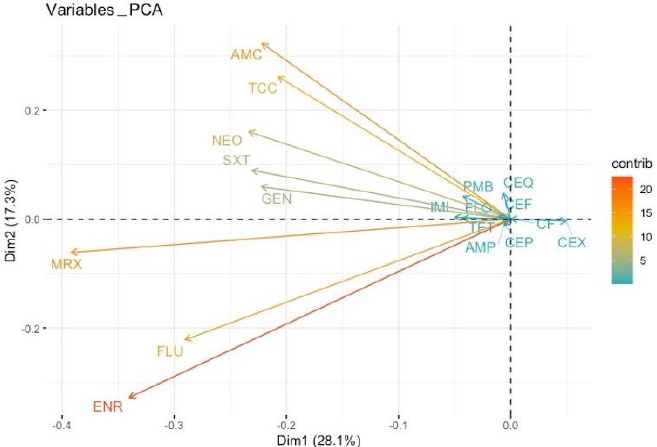
Figure 2. Principal component analysis (PCA) on co-resistances. Antibiotics are represented by vectors (arrows). Two vectors of antibiotics pointing in the same direction is an indication of a positive correlation between them; when we observe AMR in one antibiotic, we are expecting the development of AMR in the other one. An angle of 180 degrees between the vectors of two antibiotics is an indication of a negative correlation between them; when we observe AMR in one, we are not expecting the development of AMR in the other. A 90-degree angle between the vectors of two antibiotics indicates no relationship between them toward the developing AMR. The longer the vectors, the greater the intensity of this relationship. AMP: ampicillin, AMC: amoxicillin/clavulanic acid, TCC: ticarcillin/clavulanic acid, CEX: cefalexin, CF: cefalotin, CEP: cefoperazone, CEF: ceftiofur, CEQ: cefquinome, IMI: imipenem, GEN: gentamicin, NEO: neomycin, FLU: flumequine, ENR: enrofloxacin, MRX: marbofloxacin, TET: tetracycline, FLO: florfenicol, PMB: polymyxin B, SXT: trimethoprim/sulfamethoxazole (SXT).